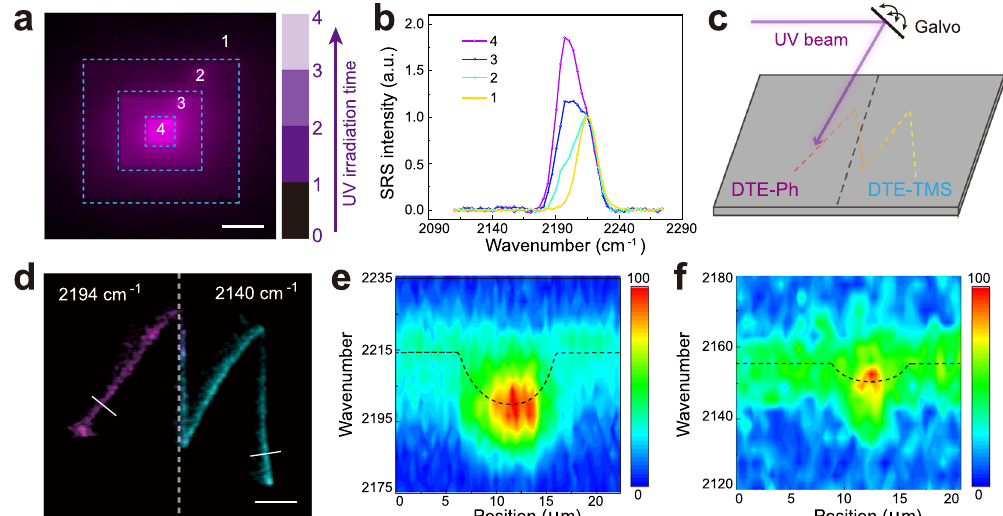
Fig. 2 Photo-switchable SRS patterning. a UV printed square areas with increasing irradiation time (0-150 µ s/pixel) exhibit increased SRS intensity (at 2194 cm − 1 ) and shifted spectra as shown in ( b ). c UV beam written letter “ M ” across the border of DTE-Ph and DTE-TMS coated areas allows dual-color SRS imaging of the two sub-portions of the letter ( d ) with varying SRS spectra along the line-cuts in the DTE-Ph ( e ) and DTE-TMS ( f ) regions. Scale bars: 10 µ m in ( a ) and 20 µ m in ( d ).